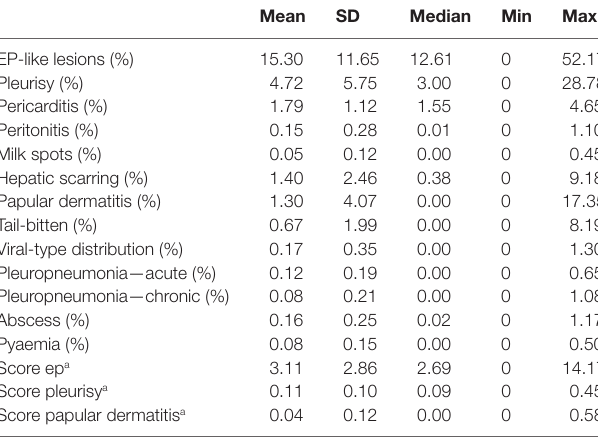
between different biosecurity scores for the fattening farms are reported in Table S1 in Supplementary Material, and those for the breeding farms in Table S2 in Supplementary